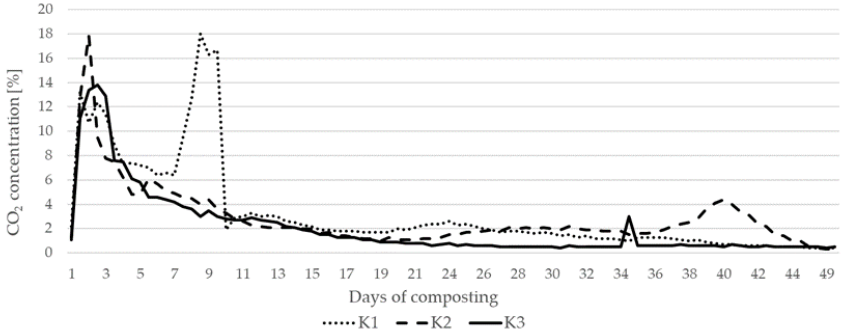
Figure 6. The carbon dioxide concentration in the exhausted gas from analyzed composts.